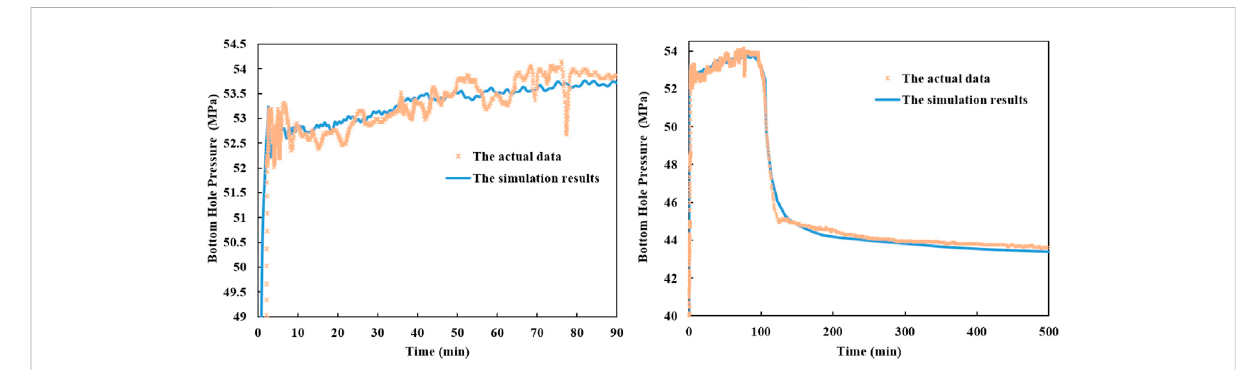
FIGURE 4 Comparison between the actual data and the simulation results in bottom hole pressure.